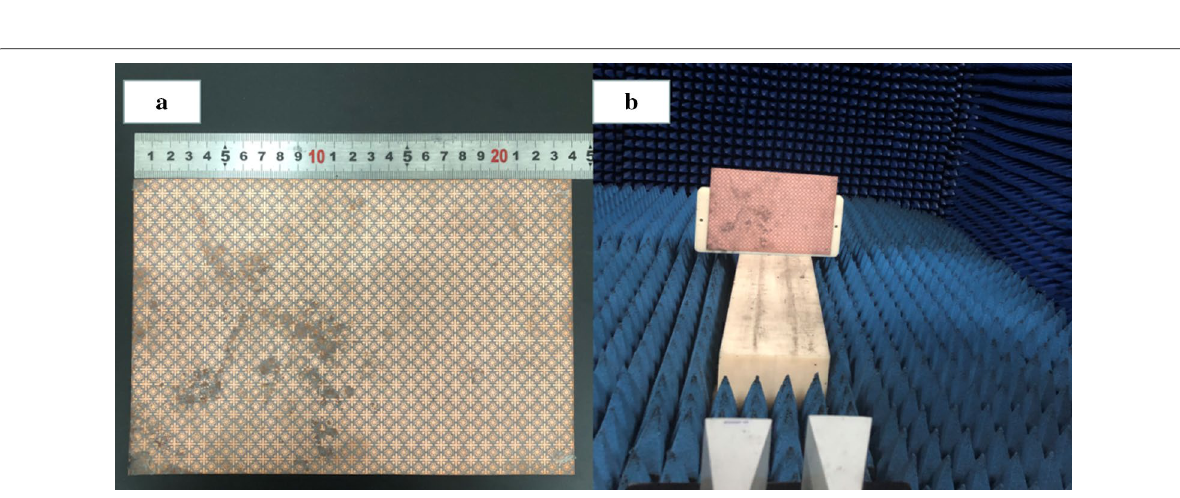
Fig. 7 a Fabricated MA prototype. b Measurement